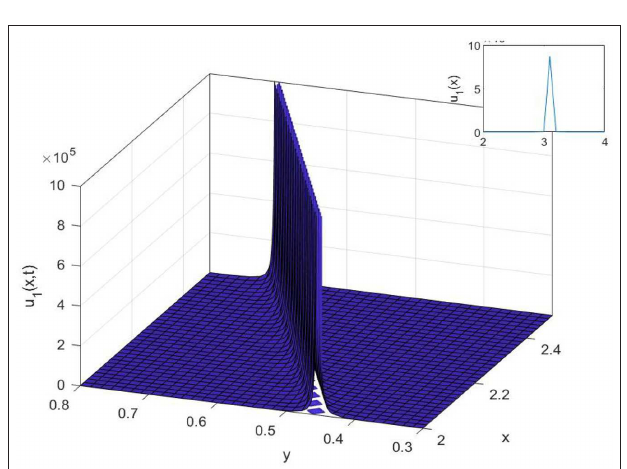
FIGURE 1 | The 3D, 2D, and contour surfaces of Equation (19) when h 2, k 2.5, α 2.6, µ 0.2, ǫ 3.5, and C 1 = = = = =